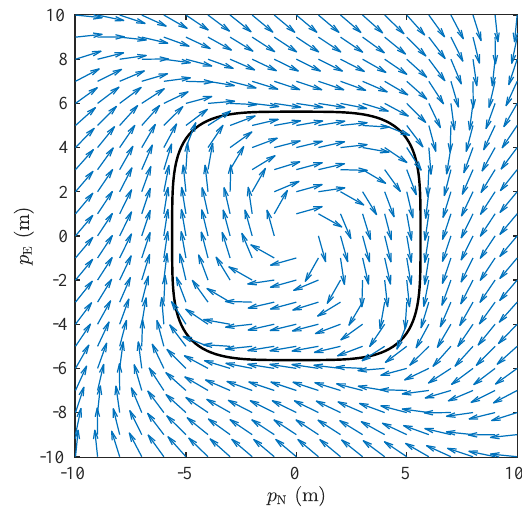
Figure 7. Vector field (blue arrows) used in this work to define a periodic MAV’s surveillance and monitoring task. By following the vector field, the vehicle will converge and circulate the solid black